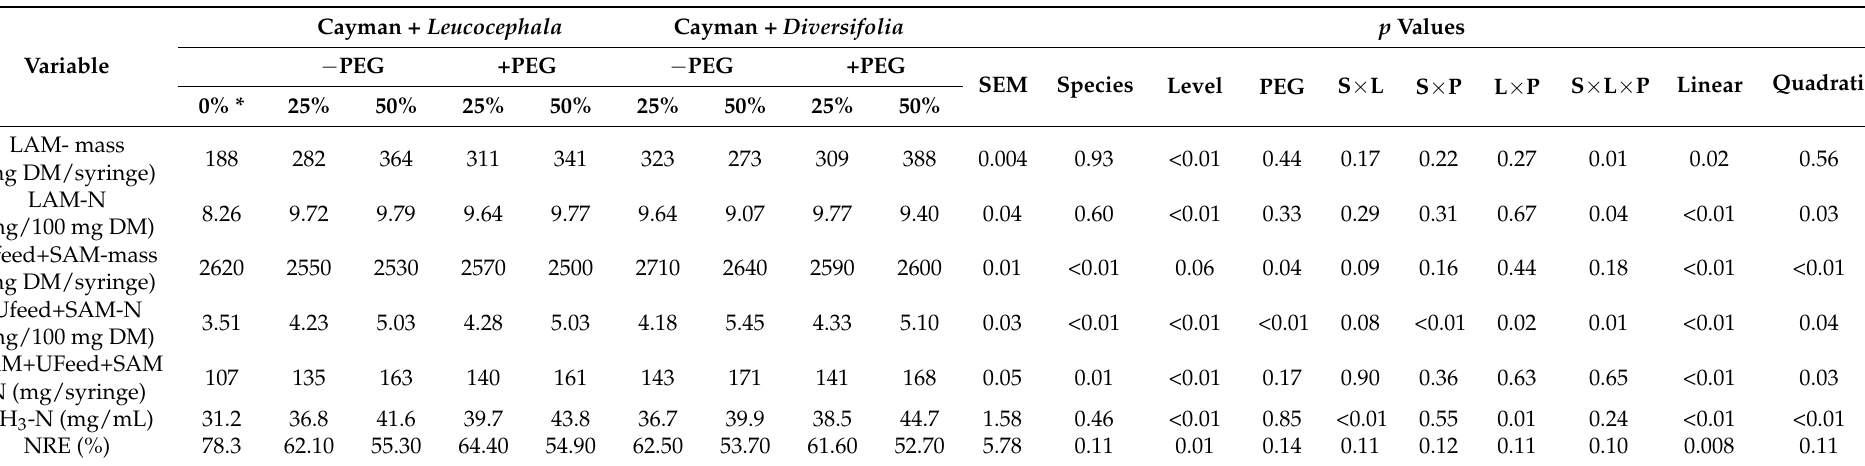
Table 4. Effect of the inclusion of Leucaena on the content of liquid-associated microbes (LAM) and undegraded feed particles+solid-associated microbes (Ufeed+SAM) after 24 h of incubation of Urochloa hybrid cv Cayman grass-based treatments. Cayman: Urochloa hybrid cv. Cayman (CIAT BR02/1752); leucocephala: Leucaena leucocephala CIAT 17263; diversifolia : Leucaena diversifolia ILRI